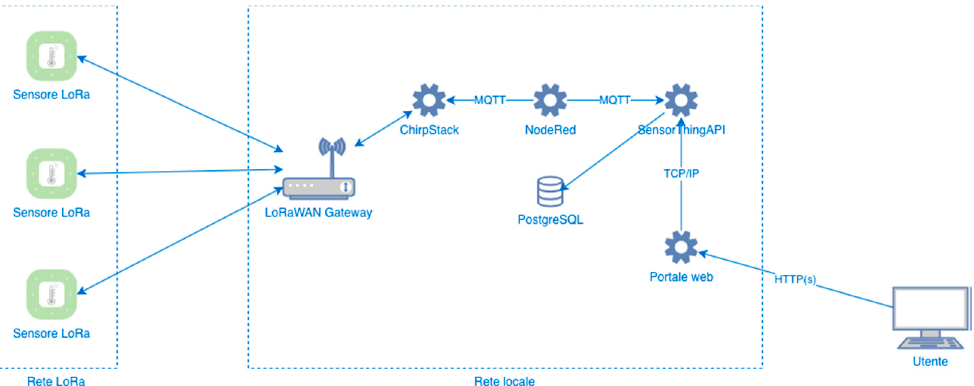
Figure 7. SyPEAH, open IP protocol.